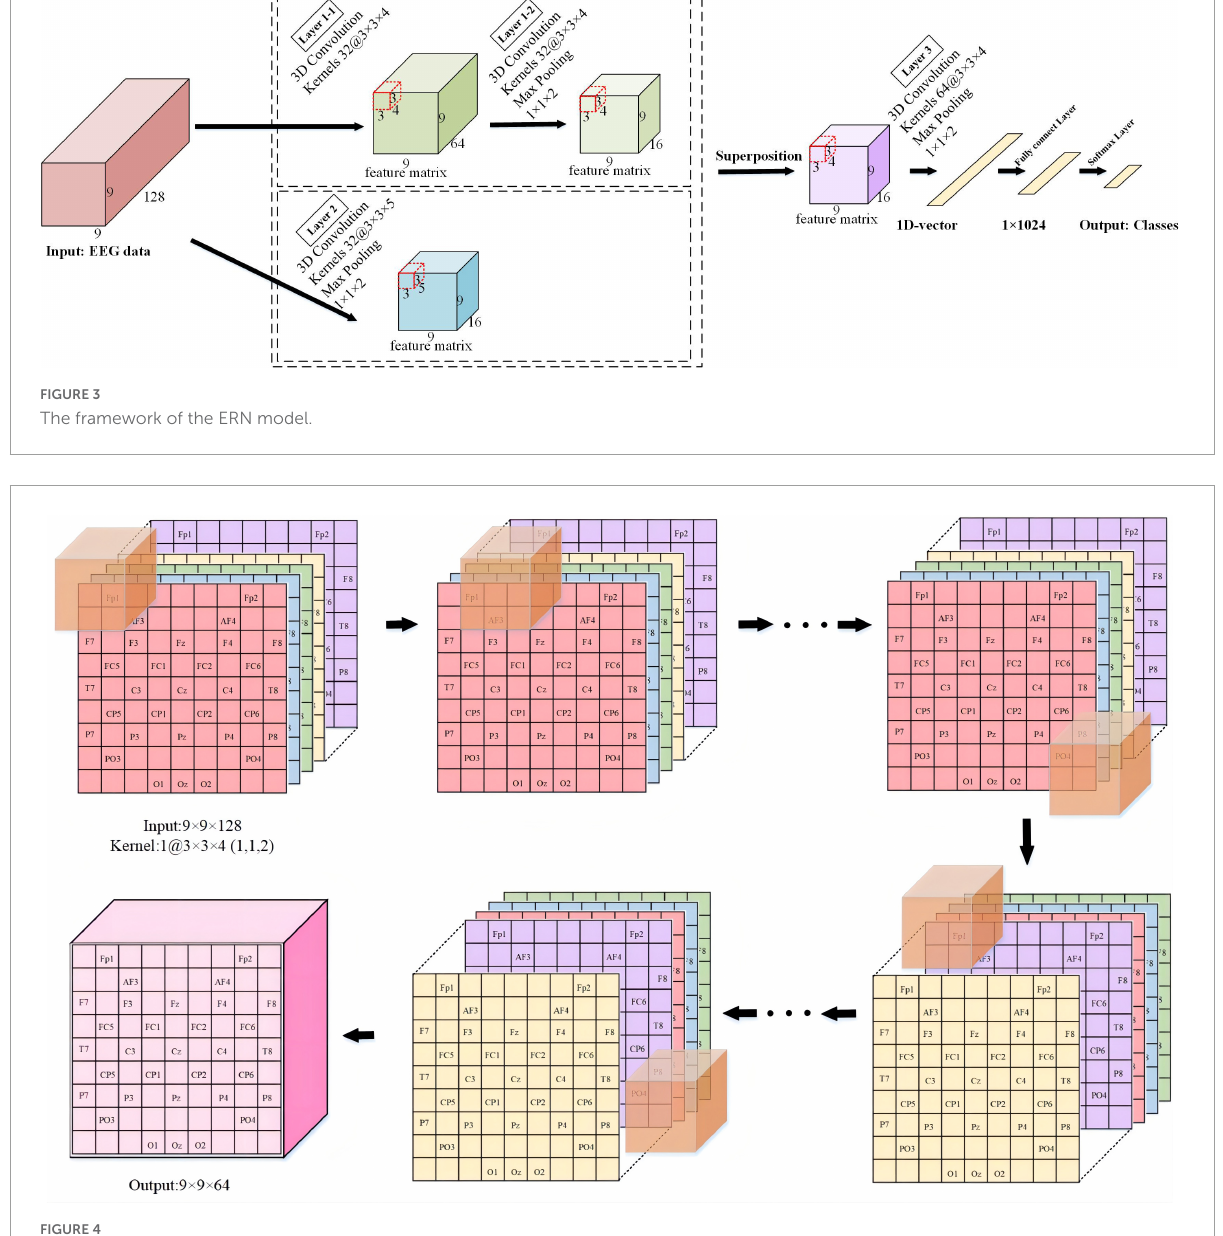
FIGURE4 The feature representation learned in ERN. (Overview of the proposed approach detailed convolutional operations).